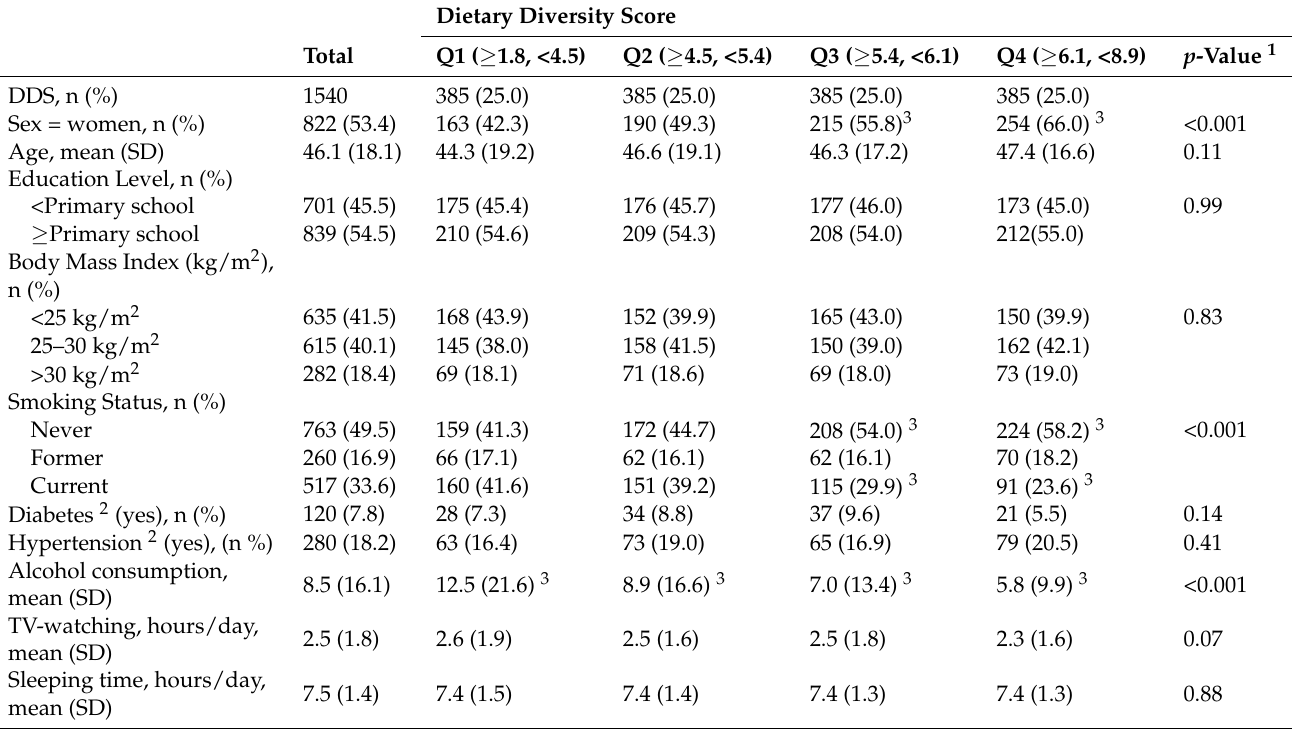
Table 2. Sociodemographic and lifestyle characteristics according to dietary diversity score among participants of the Valencia Nutrition Study in Spain ( n = 1540). Dietary Diversity